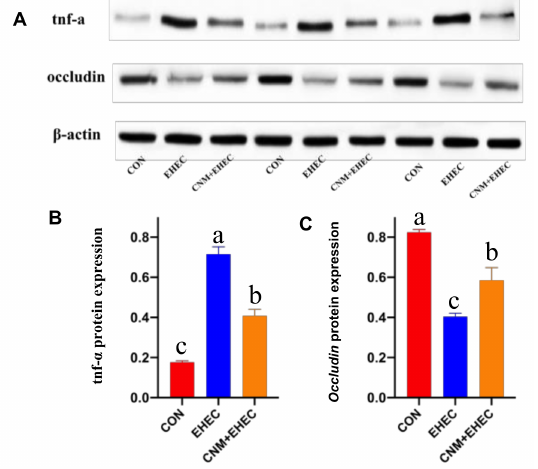
Figure 7. CNMs effectively decreased TNF- α and occludin protein expression in E. coli O157 infection. IPEC-J2 cells were treated with or without CNMs and then treated with E. coli O157 . Cells were collected and the relative abundance of TNF- α ( A , B ) and occludin ( A , C ) were measured by Western blot. Data are means ± SEM, n = 3. Means with different lowercase letters differ significantly by Tukey’s test ( p <